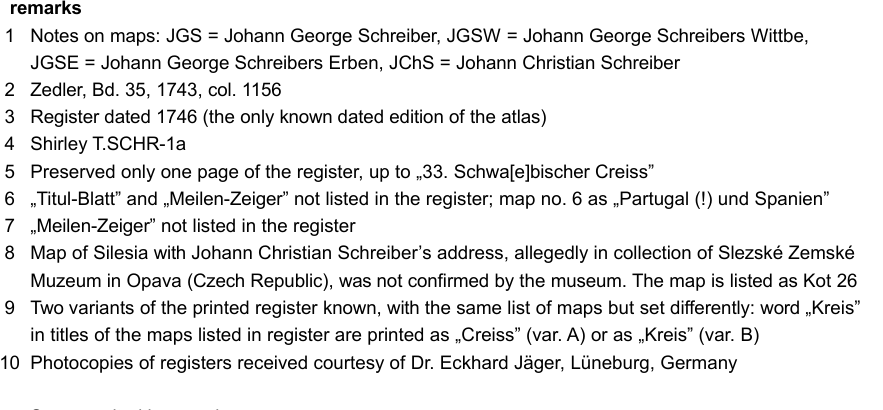
Reise Charte (...) Böhmen Breslau Iauer u.